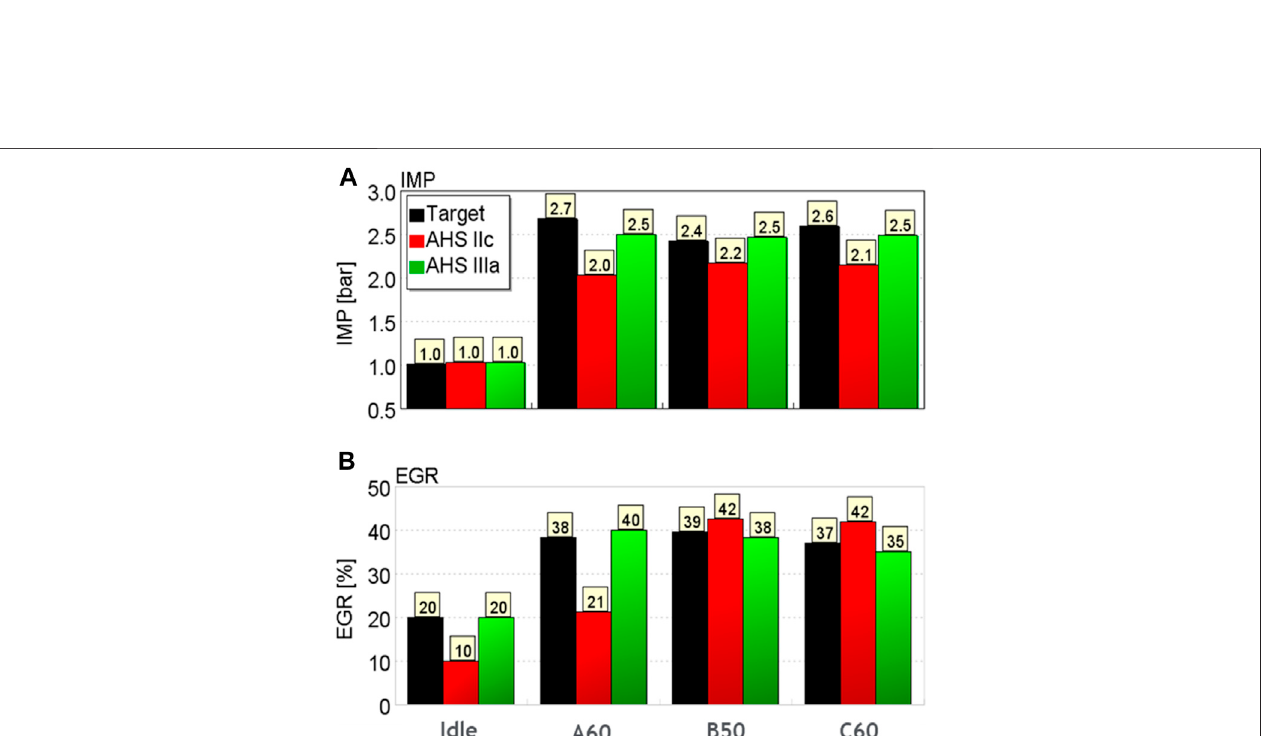
Frontiers in Mechanical Engineering |